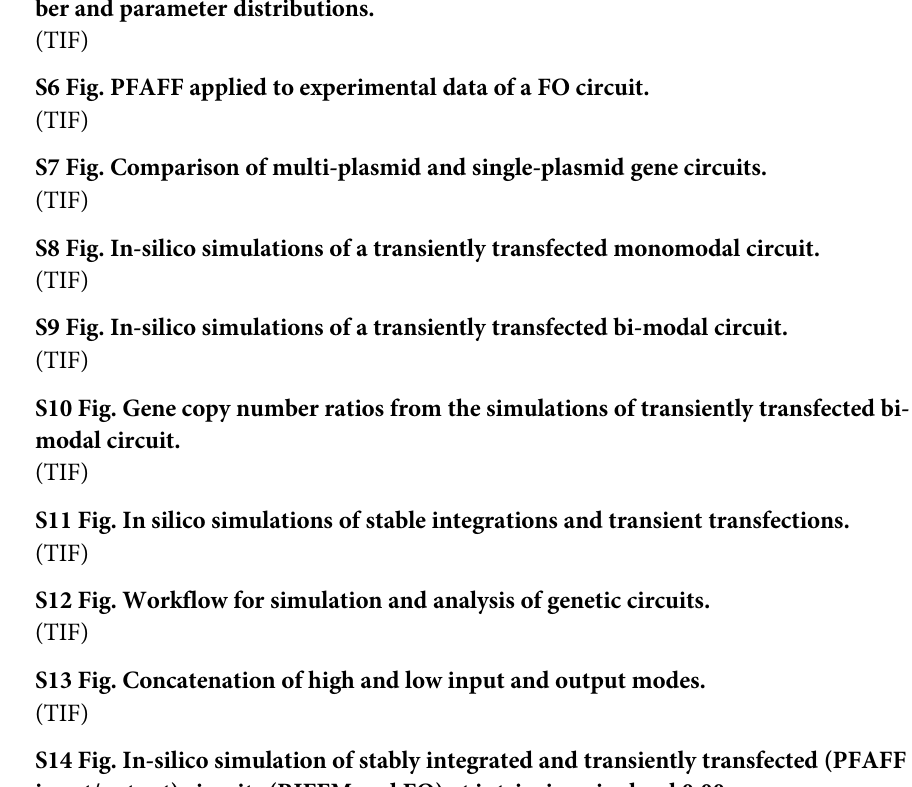
S5 Fig. In-silico simulation of transient co-transfections at various initial gene copy num- ber and parameter distributions. (TIF) S6 Fig. PFAFF applied to experimental data of a FO circuit. (TIF) S7 Fig. Comparison of multi-plasmid and single-plasmid gene circuits. (TIF) S8 Fig. In-silico simulations of a transiently transfected monomodal circuit. (TIF) S9 Fig. In-silico simulations of a transiently transfected bi-modal circuit. (TIF) S10 Fig. Gene copy number ratios from the simulations of transiently transfected bi- modal circuit. (TIF) S11 Fig. In silico simulations of stable integrations and transient transfections. (TIF) S12 Fig. Workflow for simulation and analysis of genetic circuits. (TIF) S13 Fig. Concatenation of high and low input and output modes. (TIF) S14 Fig. In-silico simulation of stably integrated and transiently transfected (PFAFF input/output) circuits (RIFFM and FO) at intrinsic noise level 0.00. (TIF) S15 Fig. In-silico simulation of stably integrated and transiently transfected (PFAFF input/output) circuits (RIFFM and FO) at intrinsic noise level 0.02. (TIF) S16 Fig. In-silico simulation of stably integrated and transiently transfected (PFAFF input/output) circuits (RIFFM and FO) at intrinsic noise level 0.04. (TIF) S17 Fig. In-silico simulation of stably integrated and transiently transfected (PFAFF input/output) circuits (RIFFM and FO) at intrinsic noise level 0.08. (TIF) S18 Fig. In-silico simulation of stably integrated and transiently transfected (PFAFF input/output) circuits (RIFFM and FO) at intrinsic noise level 0.16. (TIF) S19 Fig. In-silico simulation of stably integrated and transiently transfected (PFAFF input/output) circuits (RIFFM and FO) at intrinsic noise level 0.32. (TIF) S20 Fig. PFAFF output for various bin numbers.